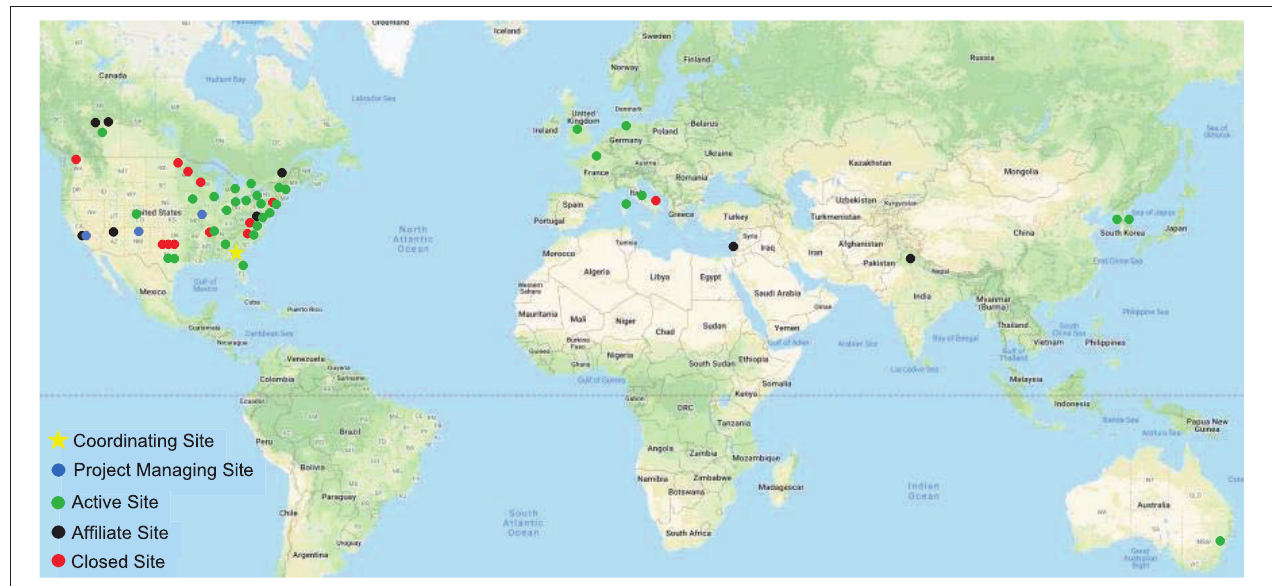
FIGURE 1 | Dystonia Coalition sites. The main coordinating center is at Emory University (star). Sites responsible for directing large multicenter projects are shown in blue. Green shows sites that recruit patients for various studies or are recipients of Pilot Project grants or Career Awards. Affiliate sites are shown in black, and closed sites are shown in